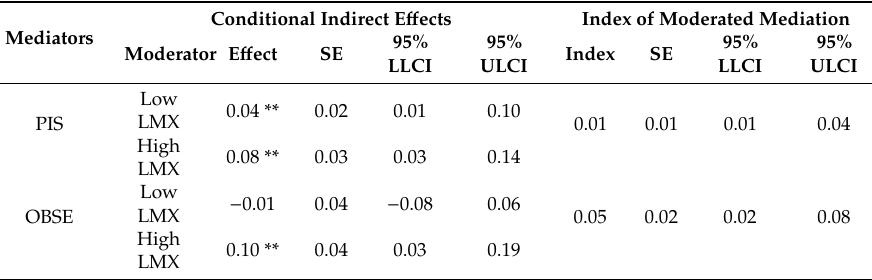
Table 3. Bootstrapping analysis results of the moderated mediation.